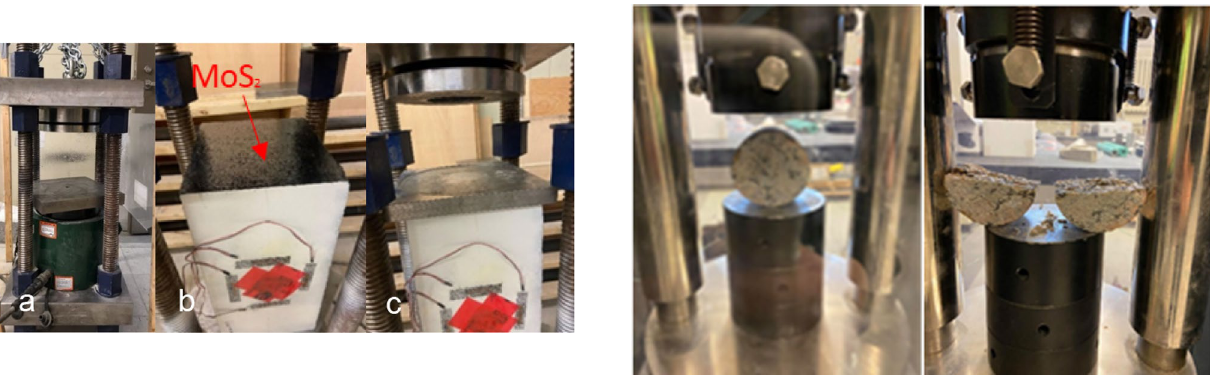
Fig. 2 Test set-up for loaded specimens: a 200-tonne uniaxial com- pressive rig; b Greased top surface of rock specimen; c Metal loading plate placed on rock specimen